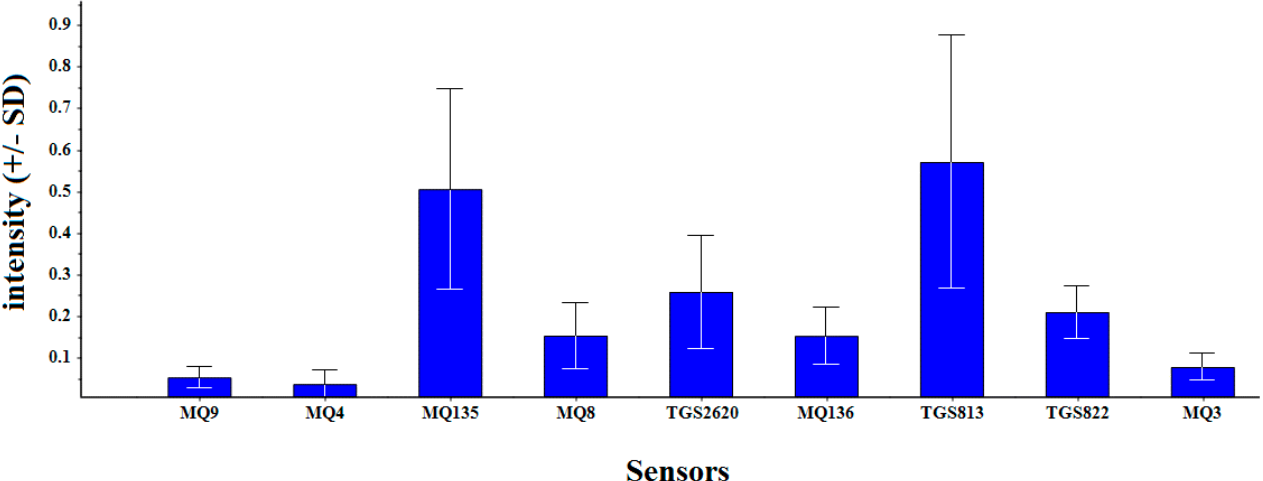
Figure 3. Example of MAU-9 e-nose sensor array output response (+/ − 1-standard deviation), indicated by individual sensor responses to essential oil sample VOC emissions in headspace, to form a bar graph smellprint pattern.